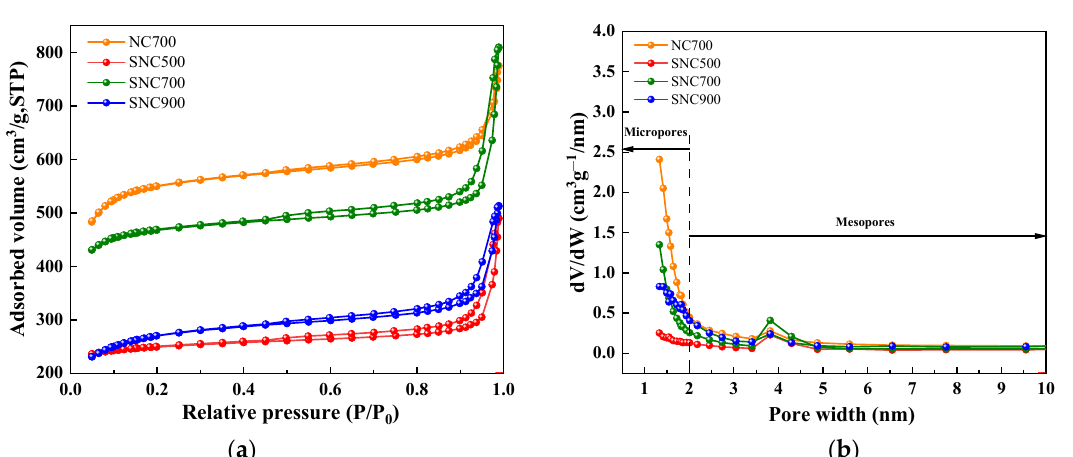
Figure 8. N 2 adsorption–desorption curves of NC and SNC carbon materials ( a ); mesoporous and microporous pore size distribution of carbon materials ( b ). Table 2. Comparison table of specific surface area and pore structure properties of carbon materials at different carbonization temperatures.